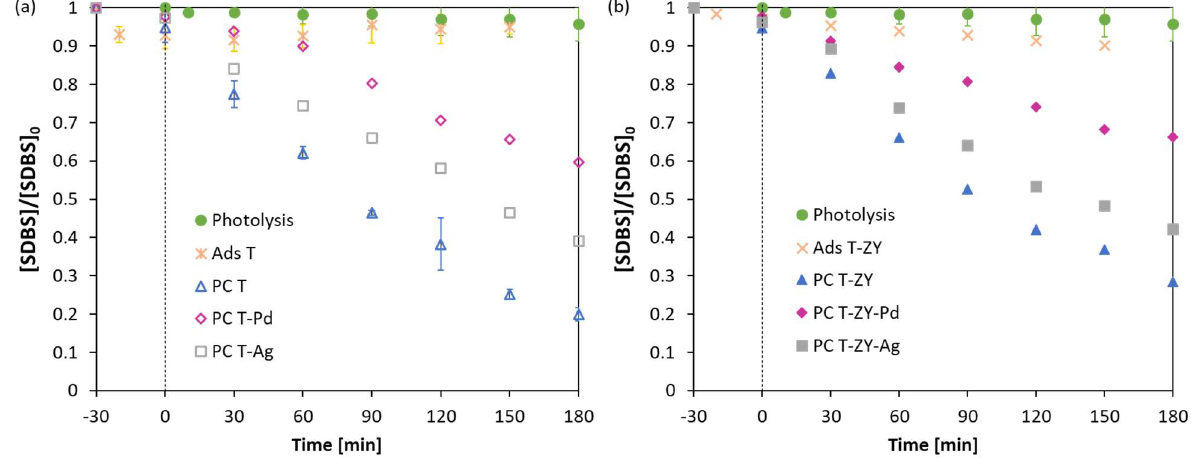
Figure 5. Change with time in dimensionless SDBS concentration in aqueous solutions in the presence of TiO 2 and TiO 2 metal composites ( a ) and T–ZY and T–ZY metal photocatalysts ( b ) irradiated with UV–A source at 365 nm. Additionally, control experiments evaluating i) SDBS adsorption in pure TiO 2 ( a ) and TiO 2 –ZY 5% mixtures ( b ) in absence of light and ii) photolysis of SDBS are included.